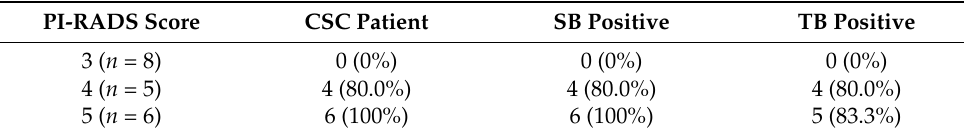
Table 2. Cancer detection rates by patients according to PI-RADS score. PI-RADS